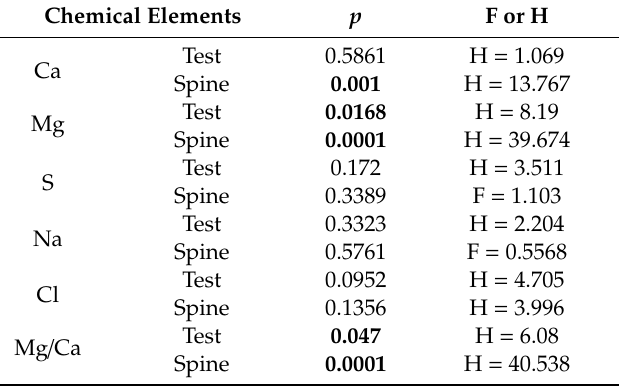
Table 1. One-way ANOVA and Kruskal–Wallis results for the elemental concentrations of spines and tests between A. lixula , P. lividus and S. granularis . Significant di ff erences ( p < 0.05 ) are highlighted in bold. (F—variance of the group means for ANOVA; H—variance of the group means for Kruskal–Wallis; p : probability value).